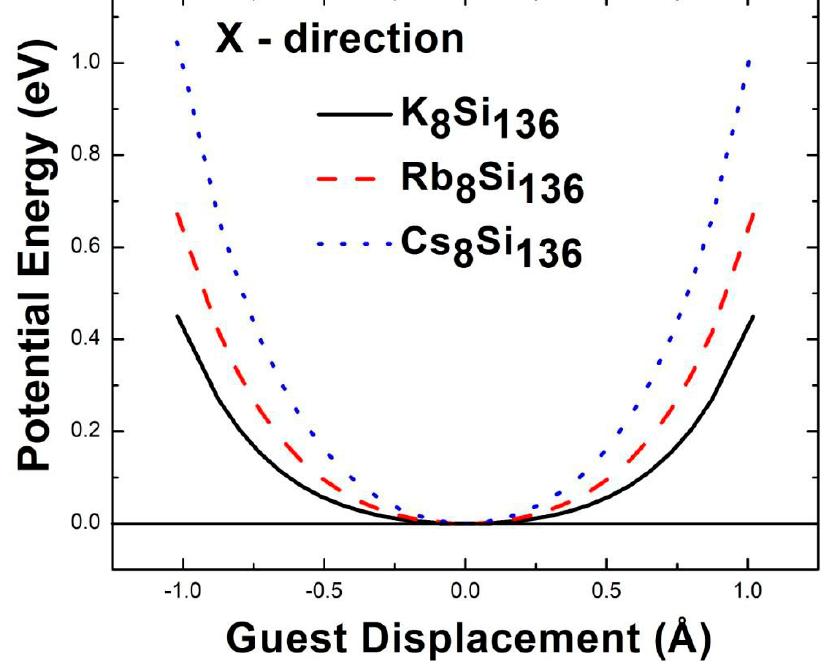
Table 1. Fitting parameters of the guest-host interaction energy potentials for A 8 Si 136 (A = Na, K, Rb, Cs) and Na 24 Si 136 .